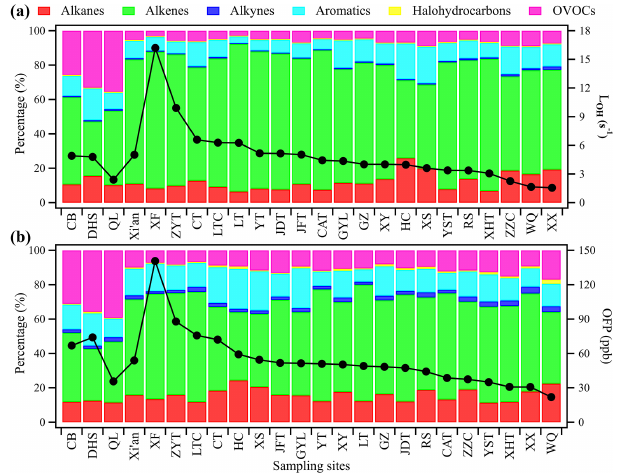
Figure 11. Contributions of different groups of VOCs to (a) L OH and (b) OFP in different sites in Xi’an.